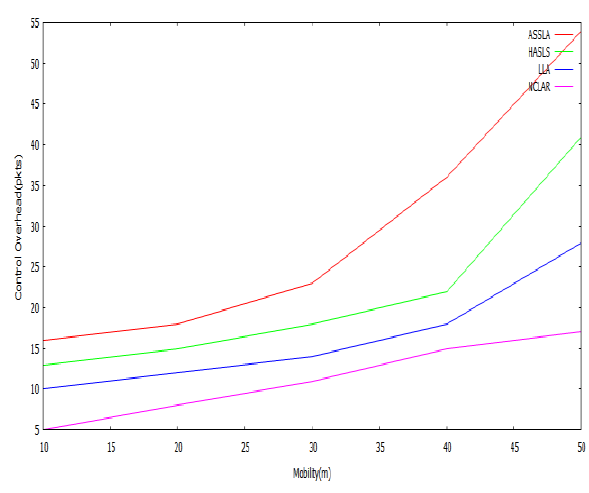
Figure 8. Control Overhead Vs Mobility